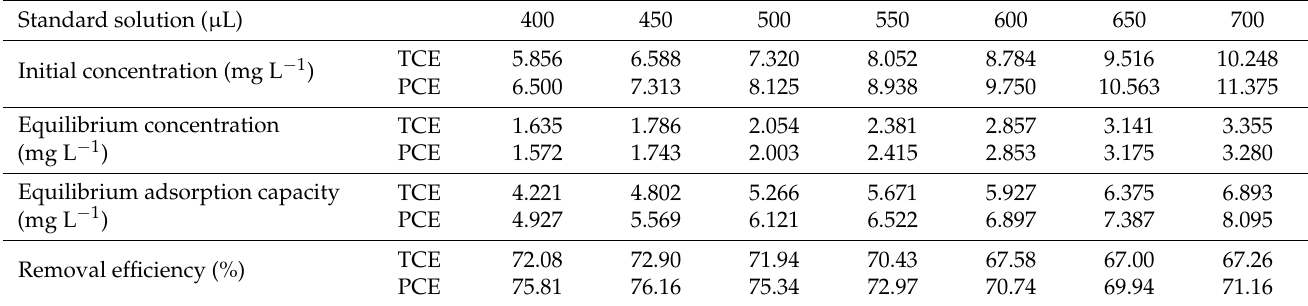
Table 7. Experimental data of silica gel for different initial concentrations of TCE and PCE.